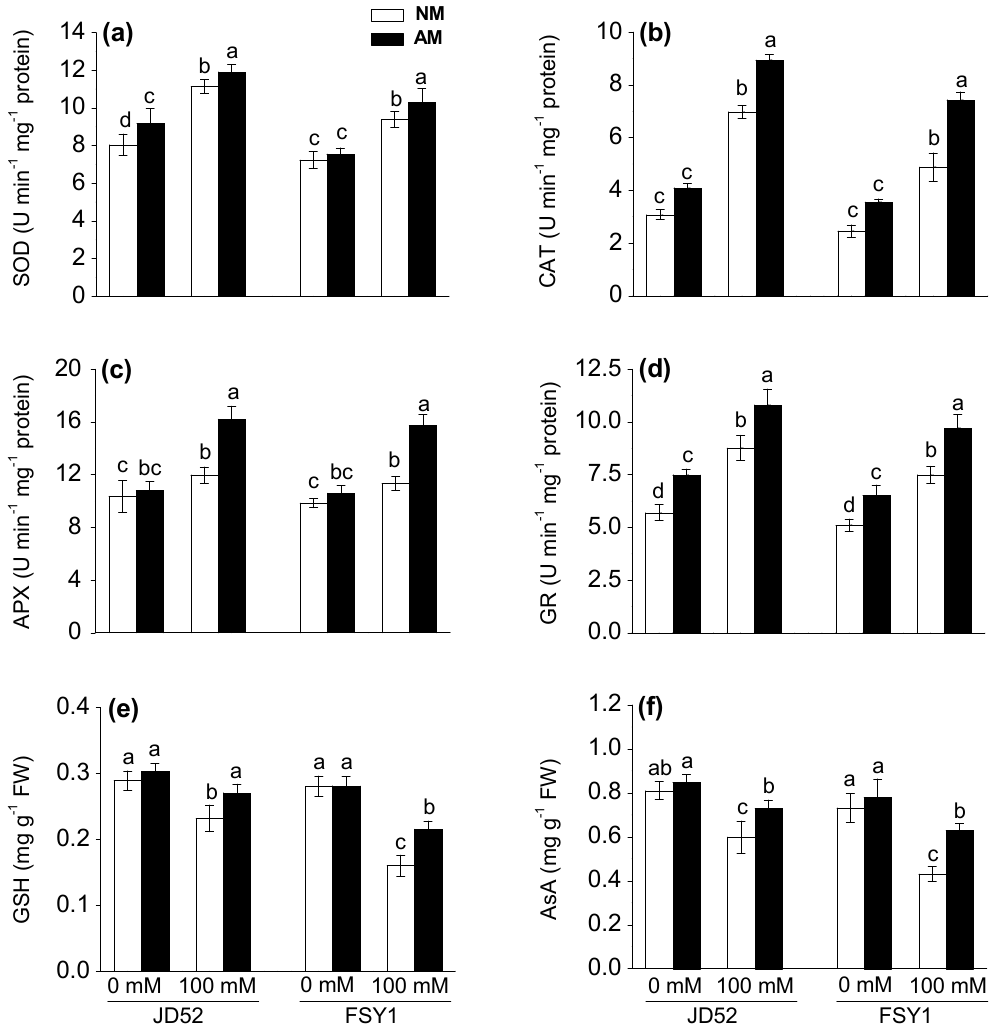
Figure 5. Superoxide dismutase (SOD) ( a ), catalase (CAT) ( b ), ascorbate peroxidase (APX) ( c ), and glutathione reductase (GR) ( d ) activities, and reduced glutathione (GSH) ( e ) and ascorbate (AsA) ( f ) contents in two maize genotypes (JD52 and FSY1) inoculated with Funneliformis mosseae (AM) or without inoculation (NM) in 0 and 100 mM NaCl treatments assessed at 59 DAS. For each trait, bars with different letters indicate significant differences ( p ≤ 0.05).